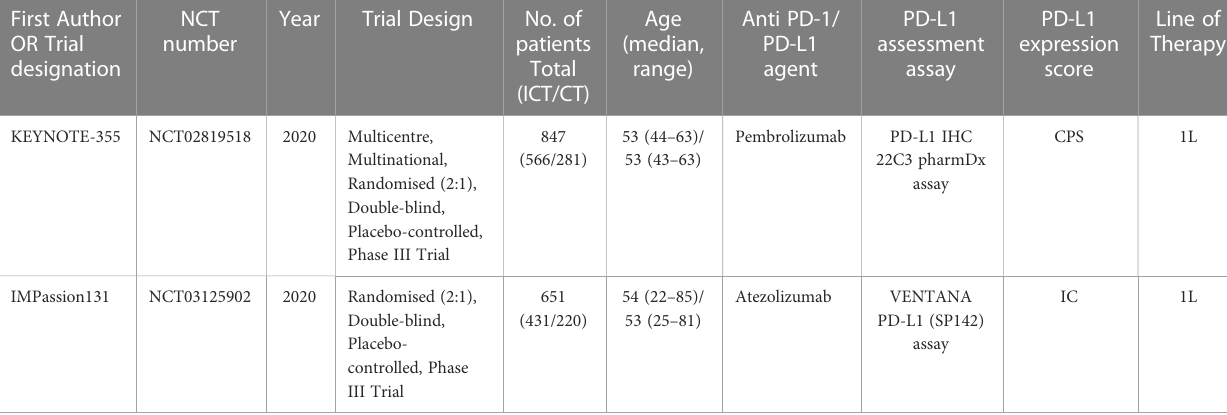
shown with increasing PD-L1 expression (p=0.012)